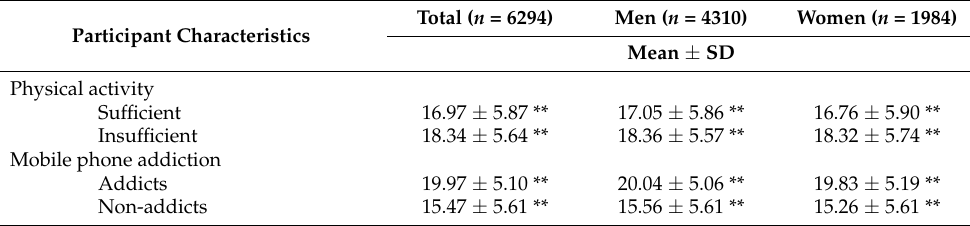
Table 2. The Pearson correlation coefficient for the degree of irrational procrastination exhibited by the participants (IPS score) and across different groups.